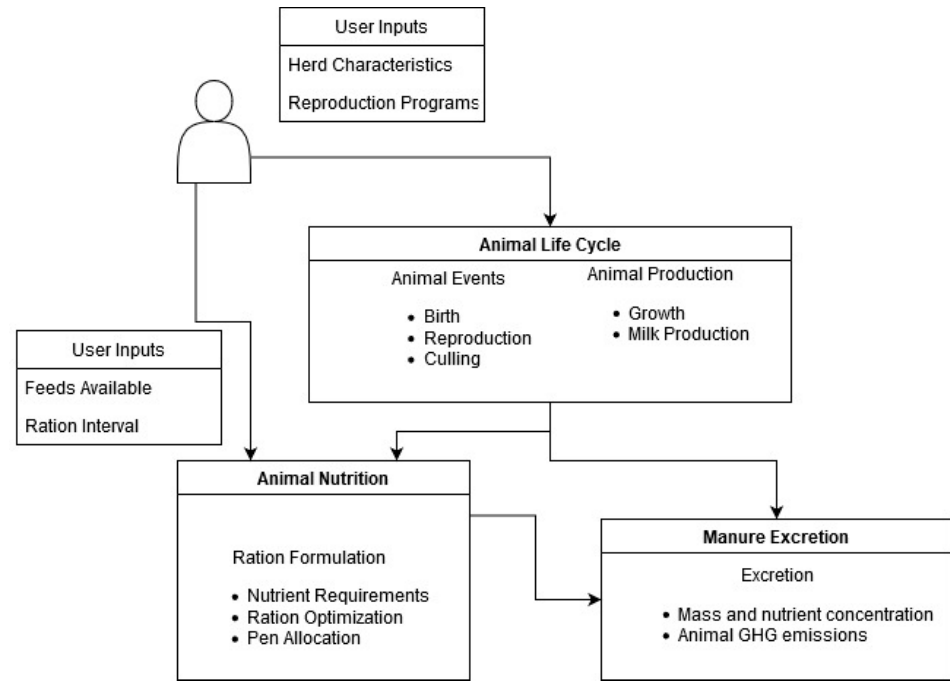
Figure 2. User inputs and main routines of the animal module in the Ruminant Farm Systems model.